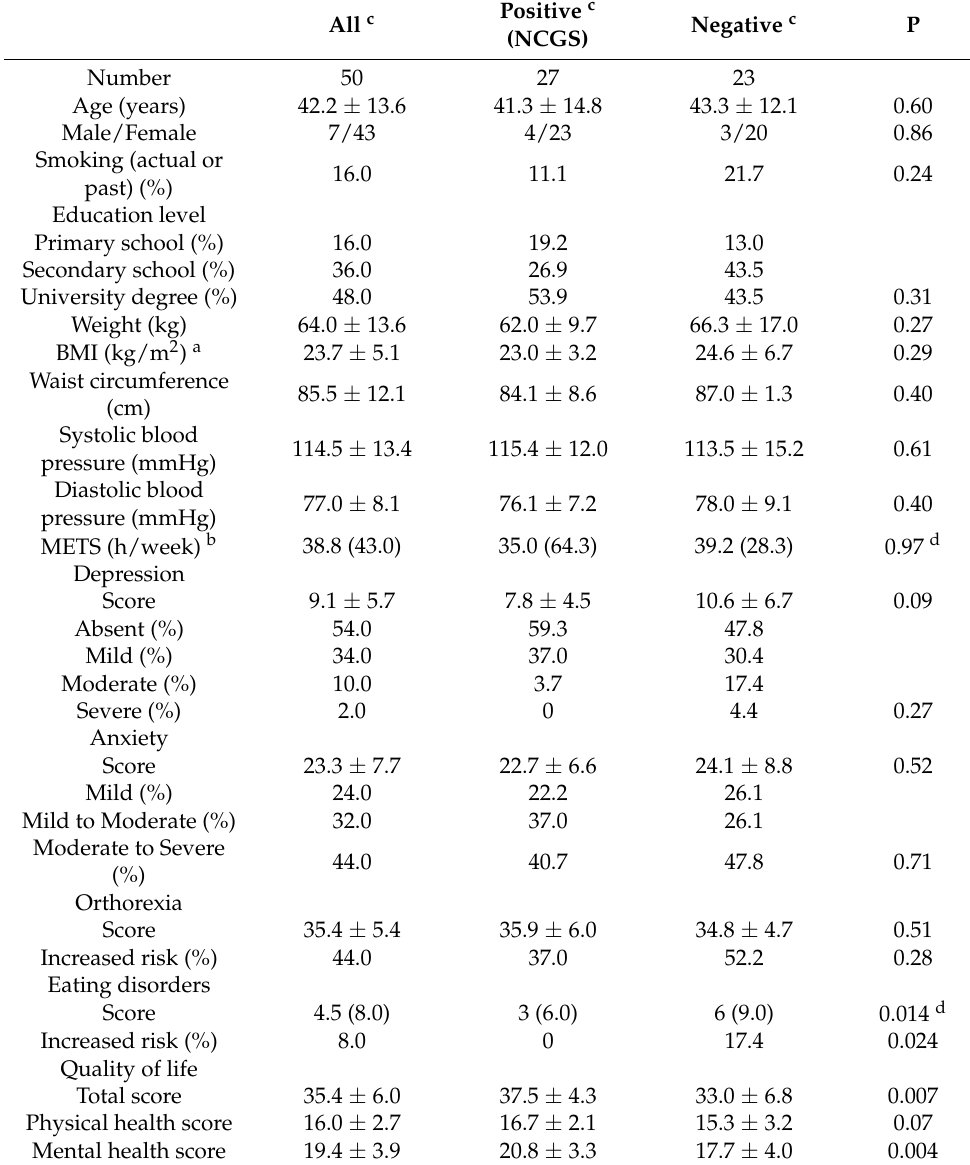
Table 1. Characteristics of the enrolled participants by their response to the double-blind placebo- controlled (DBPC)